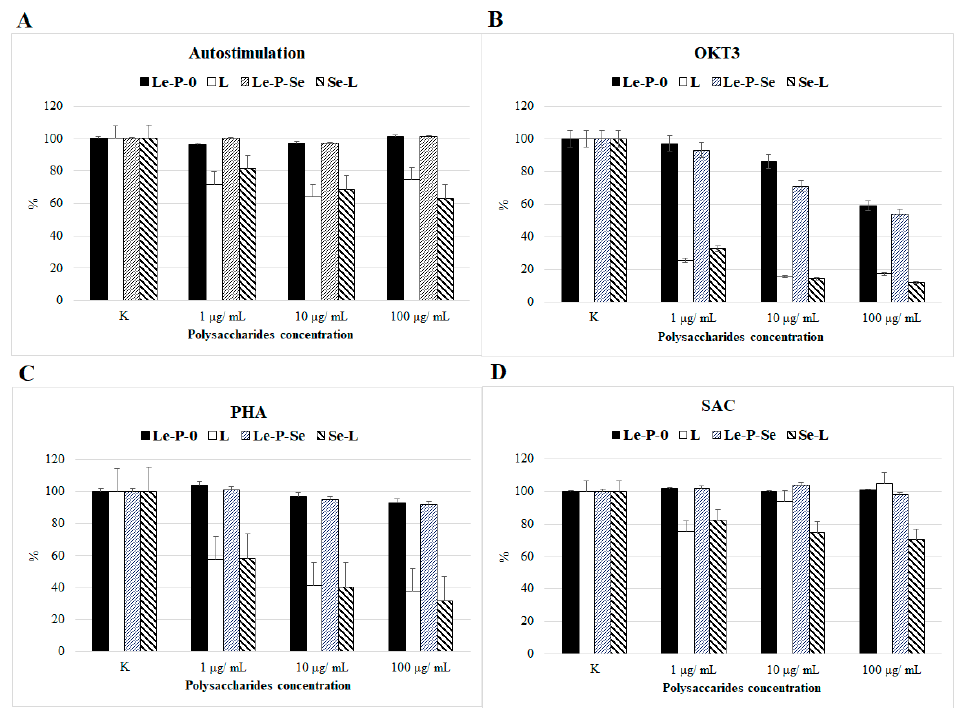
Figure 14. Comparison of the effects of exopolysaccharides isolated from the culture medium (Le-P-Se, Le-P-0) and polysaccharides extracted from the mycelial biomass (selenated—Se-L and not selenated L) [25] on proliferation of peripheral blood mononuclear cells (PBMCs). ( A ) Non-stimulated (autostimulation) and stimulated with: ( B ) Anti-CD3 monoclonal antibody (OKT3); ( C ) Phytohemagglutinin (PHA); and ( D ) Suspension of Staphylococcus aureus Cowan strain (SAC). The results are presented as the percentage of proliferation in control cultures (without polysaccharides). The error bars correspond to the standard